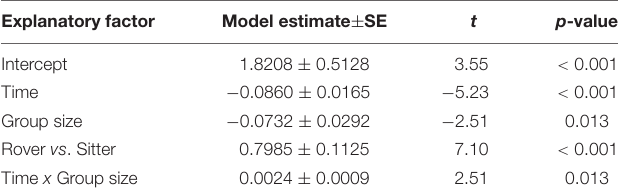
TABLE 4 | Factors influencing the proportion of Drosophila melanogaster larvae found in contact with Aspergillus nidulans colonies in Experiment 3. Results of the most parsimonious GLM (after backward elimination of non-significant factors) are shown.